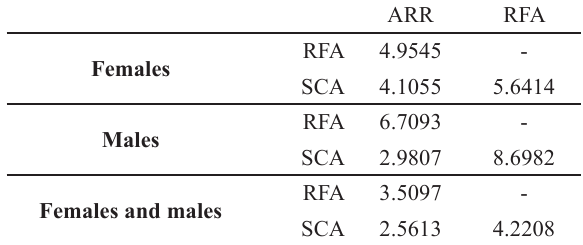
Fig 10 . Canonical Variate Analysis (CVA) for morphometric variation of the wing shape based on the joint analysis of males and females (A), only females (B) and only males (C). The samples of São Carlos, Rifaina, and Araras are indicated by the colors orange, grey and black, respectively. Table 6 . Mahalanobis distances of wing size between females and males of P. denticulatum from the three study sites (ARR: Araras-SP, RFA: Rifaina-SP, SCA: São